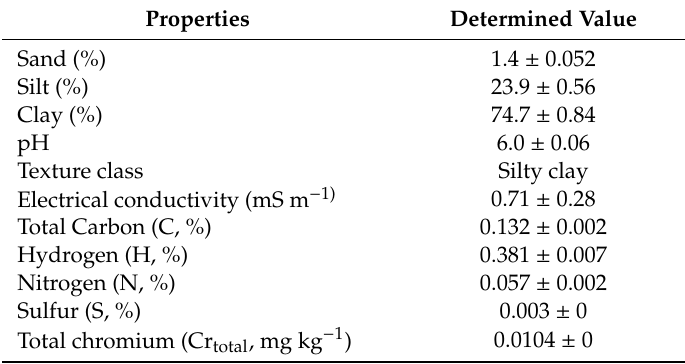
Table 4. Physico-chemical properties of the background